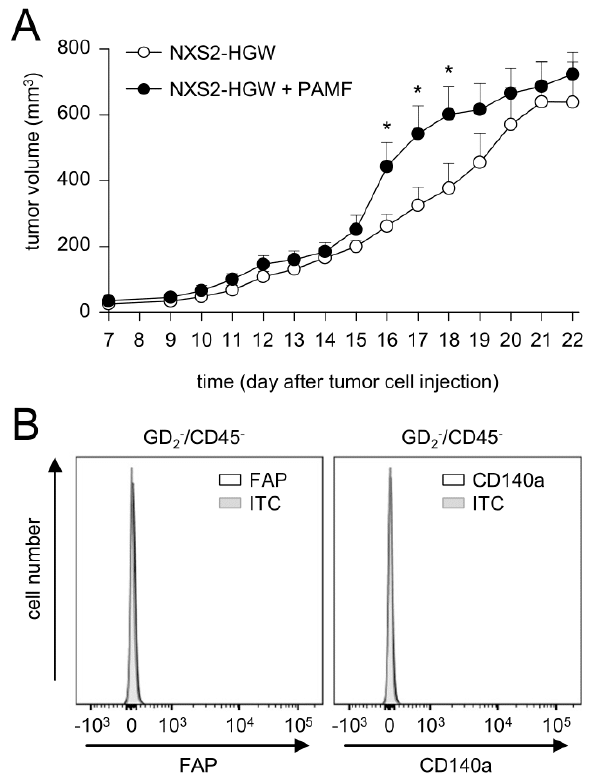
Figure 6. Impact of PAMF on tumor growth. ( A ) Analysis of tumor growth in mice injected with either NXS2-HGW (open circles) or NXS2-HGW in combination with PAMF (closed circles). Tumors were surgically resected on day 22 after tumor cell injection. Co-injection was performed at the tumor-cell-to-PAMF ratio of 2:1. When mice were sacrificed ahead of schedule due to tumor burden, the last measurement was included into the calculation of tumor growth at subsequent time points. Data are given as mean + SEM. * p < 0.05, t -test ( B ) Representative histograms of flow cytometry analysis of FAP and CD140a levels in tumor tissue of mice injected with NXS2-HGW in combination with PAMF. To detect CAFs (FAP+/CD140a+), leukocytes and tumor cells were excluded from the analysis using CD45 and GD 2 expression,